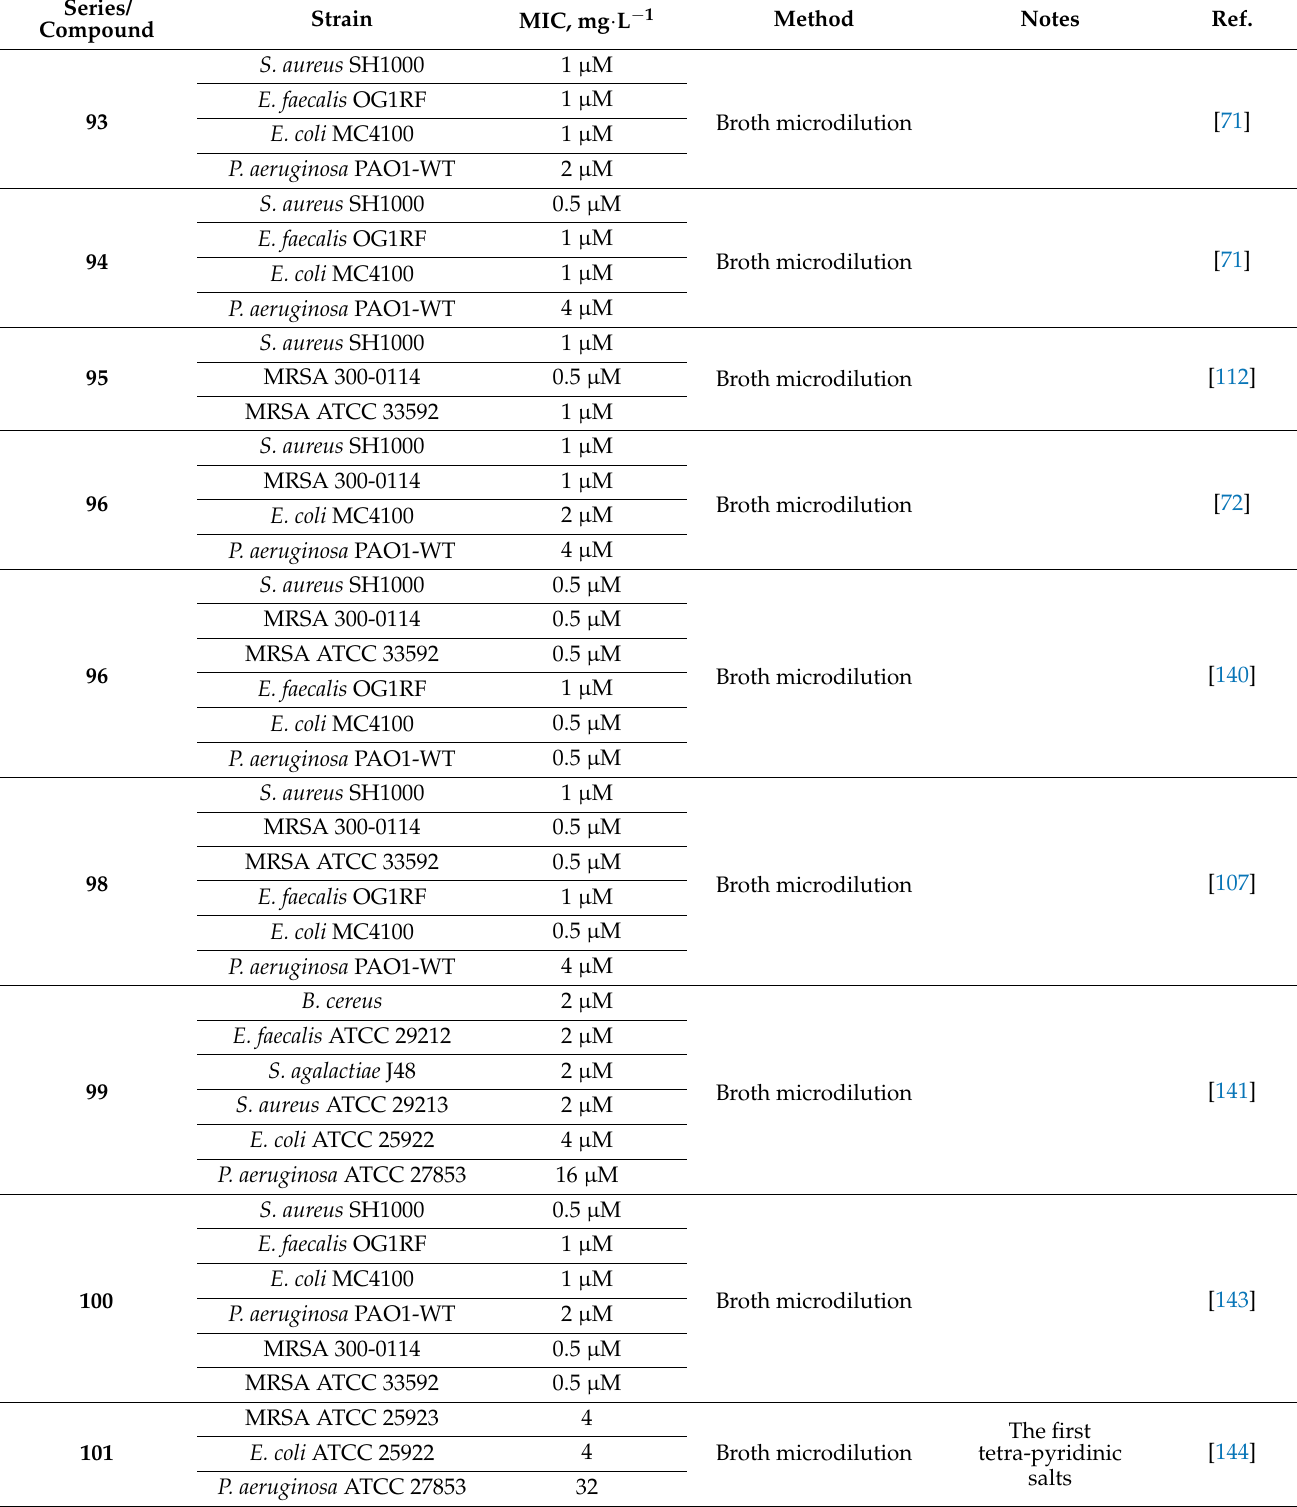
Table 6. Antimicrobial activity of multi-QACs